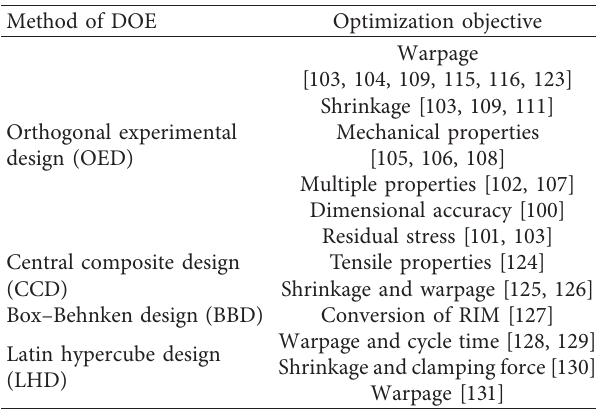
Table 1: A brief summary of DOE methods for injection molding